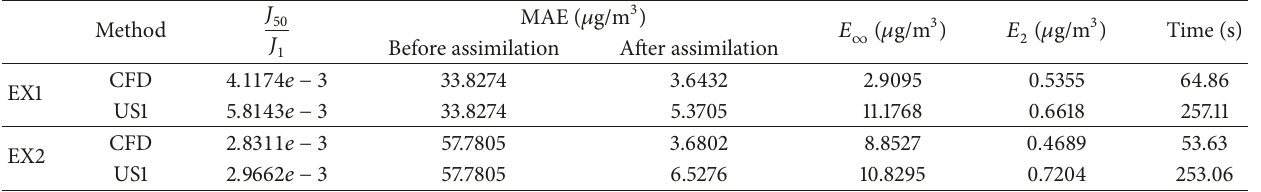
Table 4: 𝐽 50 /𝐽 1 , errors, and run time inverted by the adjoint assimilation method with different